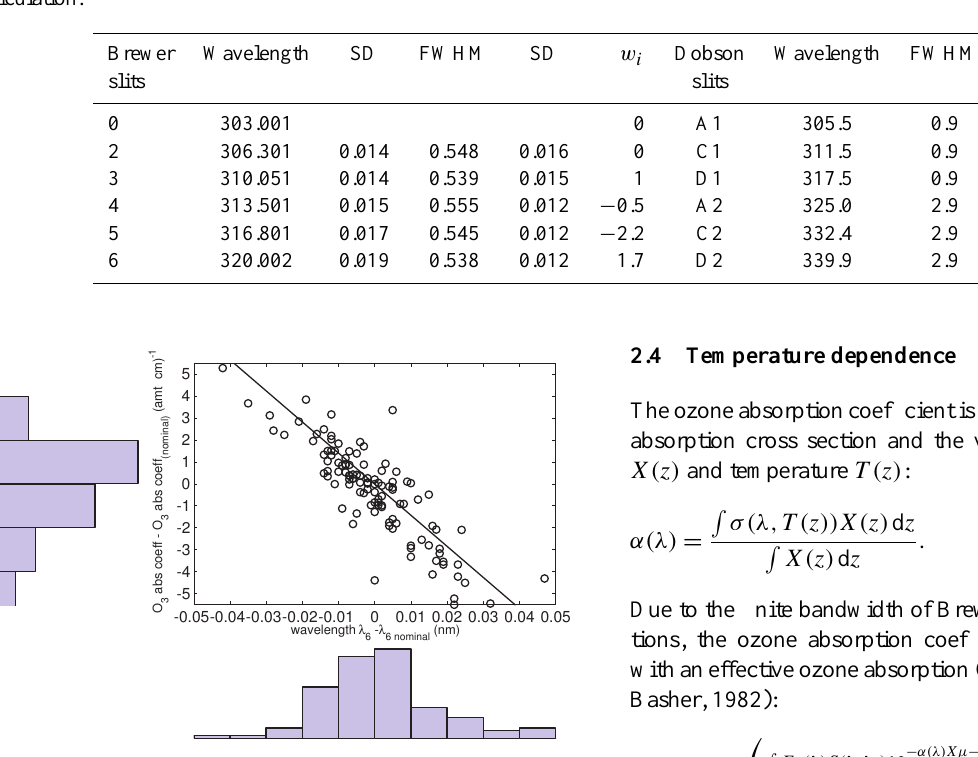
Table 1. Wavelengths and weighting coefficients used in the Dobson and Brewer operative algorithms. The Brewer values are the mean and standard deviation of central wavelength and full width at half maximum (FWHM) of the slits of the “average” Brewer instrument determined during RBCC-E campaigns . The Dobson values correspond to the nominal values published in the Dobson handbook. The values for the World Standard Dobson 83 are available from Komhyr et al. (1993). Note that only the last four wavelengths are used for the Brewer ozone calculation.